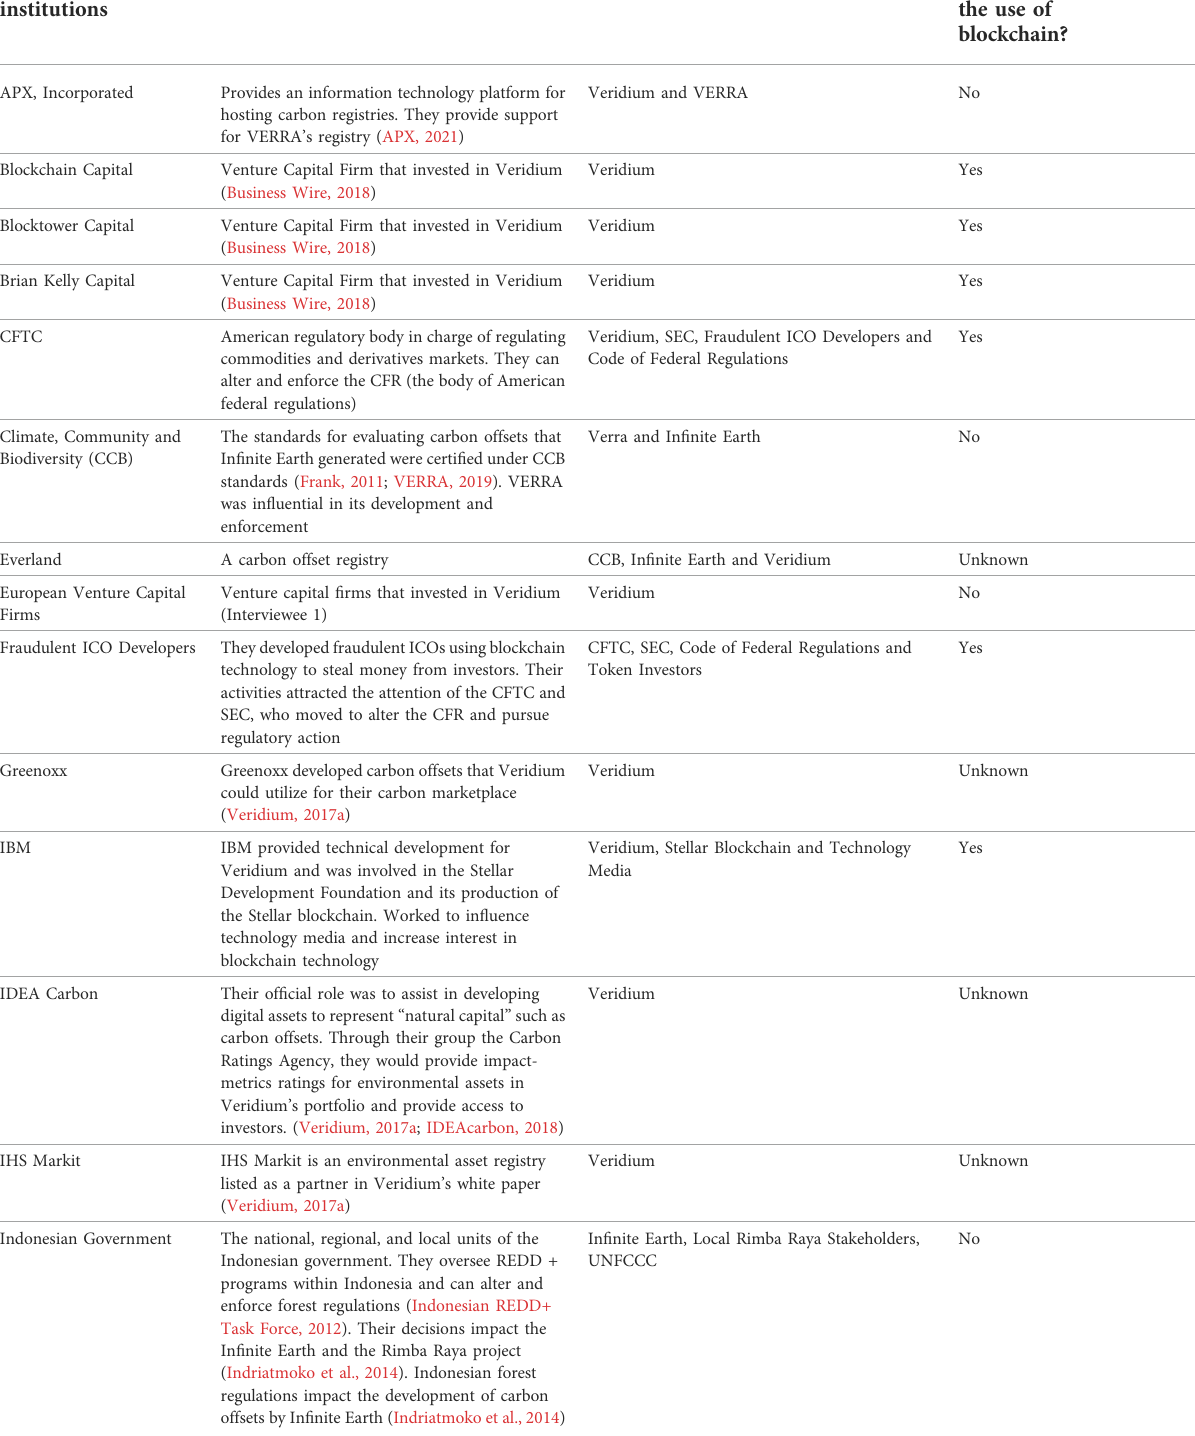
TABLE 2 List of stakeholders, role within the network, and their key relationships. Several are listed as partners in early documents. However, it is unclear if they were still involved at the time of data collection. 7 Stakeholders and Role in the network Key relationships Present due to institutions